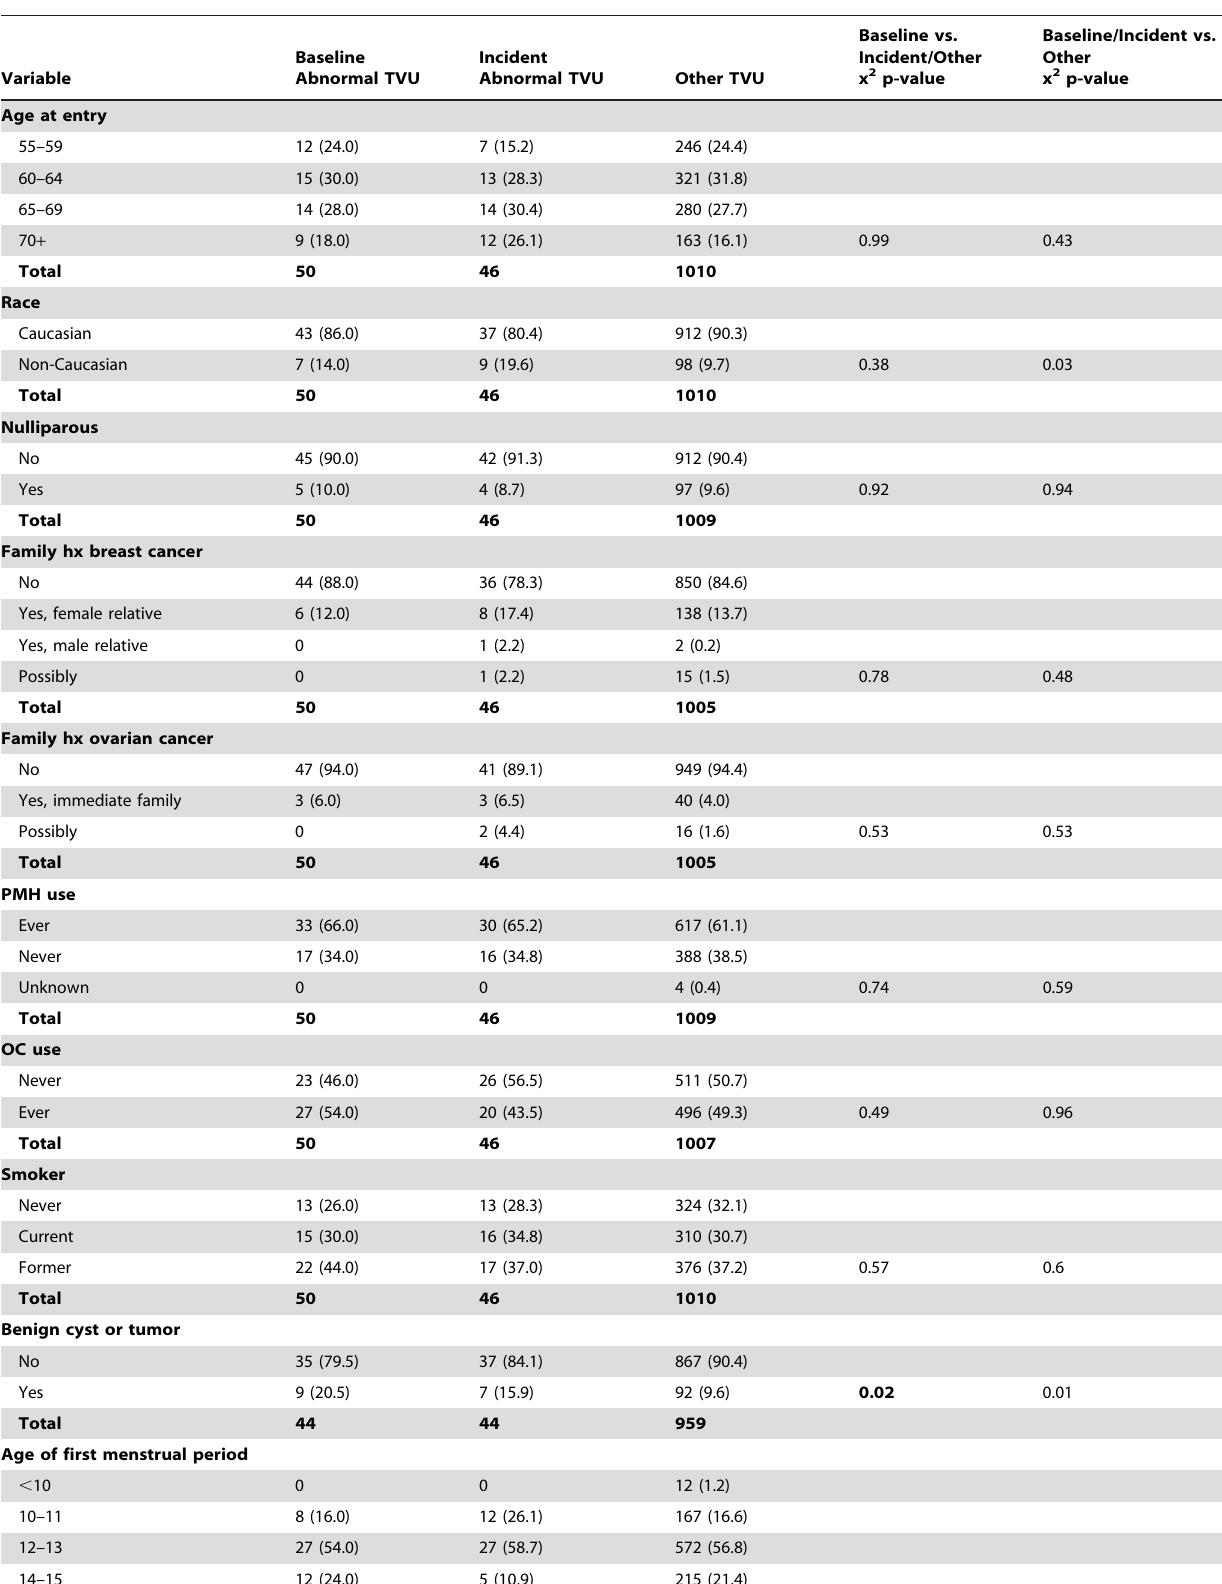
Table 1. Risk factors and screening results in the subgroup with SNP